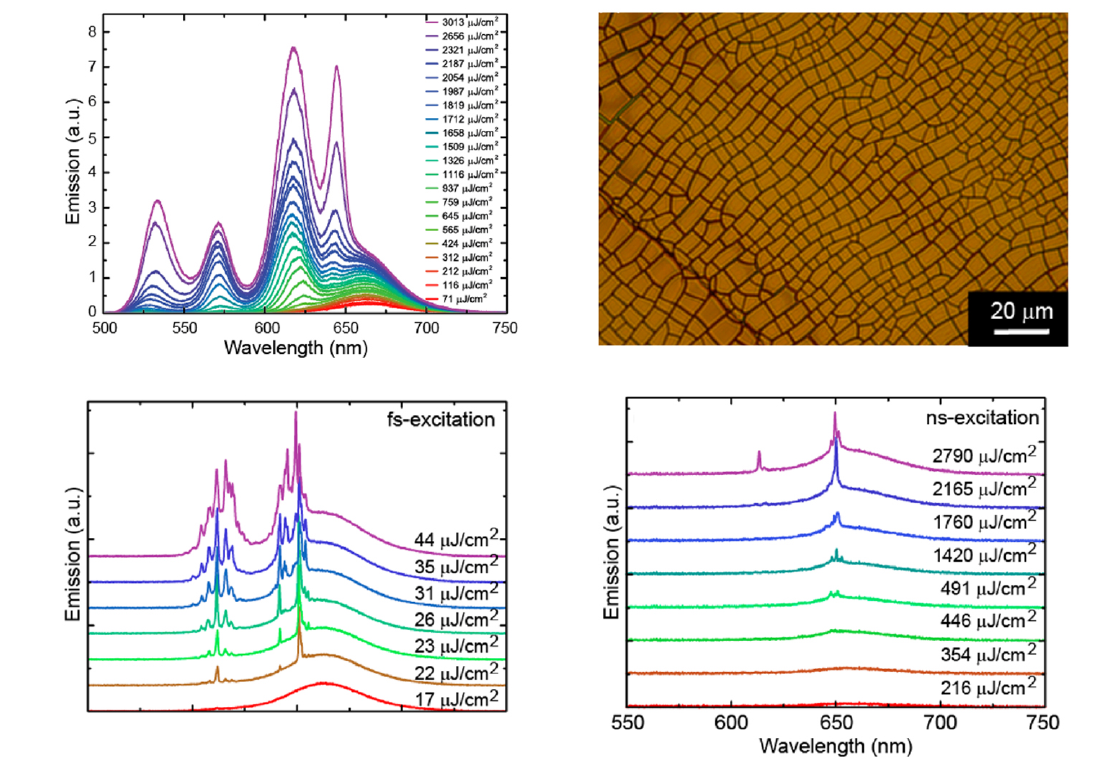
Figure 10. ( top left ) Excitation density dependence of the PL spectra of a blended film of 4.1 and 7.5 nm core diameter CdSe/CdS g-NCs under fs pulses pumping, showing broadband optical gain from 510 to 650 nm. ( top right ) Microscope image of an area with high density of cracks of the film of g-NCs with a 7.5 nm core diameter. ( bottom left ) Emission spectra showing simultaneous random lasing in different bands under femtosecond pulsed excitation. ( bottom right ) Emission spectra showing simultaneous random lasing in different bands under nanosecond pulsed excitation. Adapted from [80]. American Chemical Society,